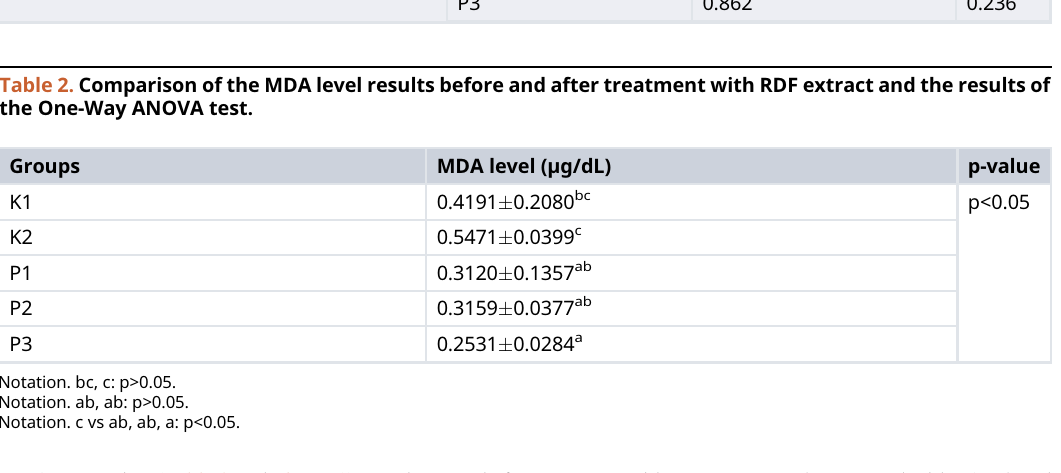
MDA expression (Table 2 and Figure 1) was decreased after treatment with RDF extract K2 compared with P1, P2 and